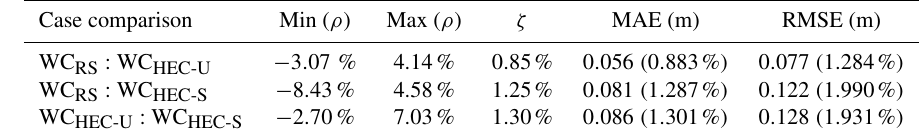
Table 6. Difference metrics for Waller Creek simulation results. Nondimensional MAE and RMSE are shown in parentheses. Case comparison Min ( ρ